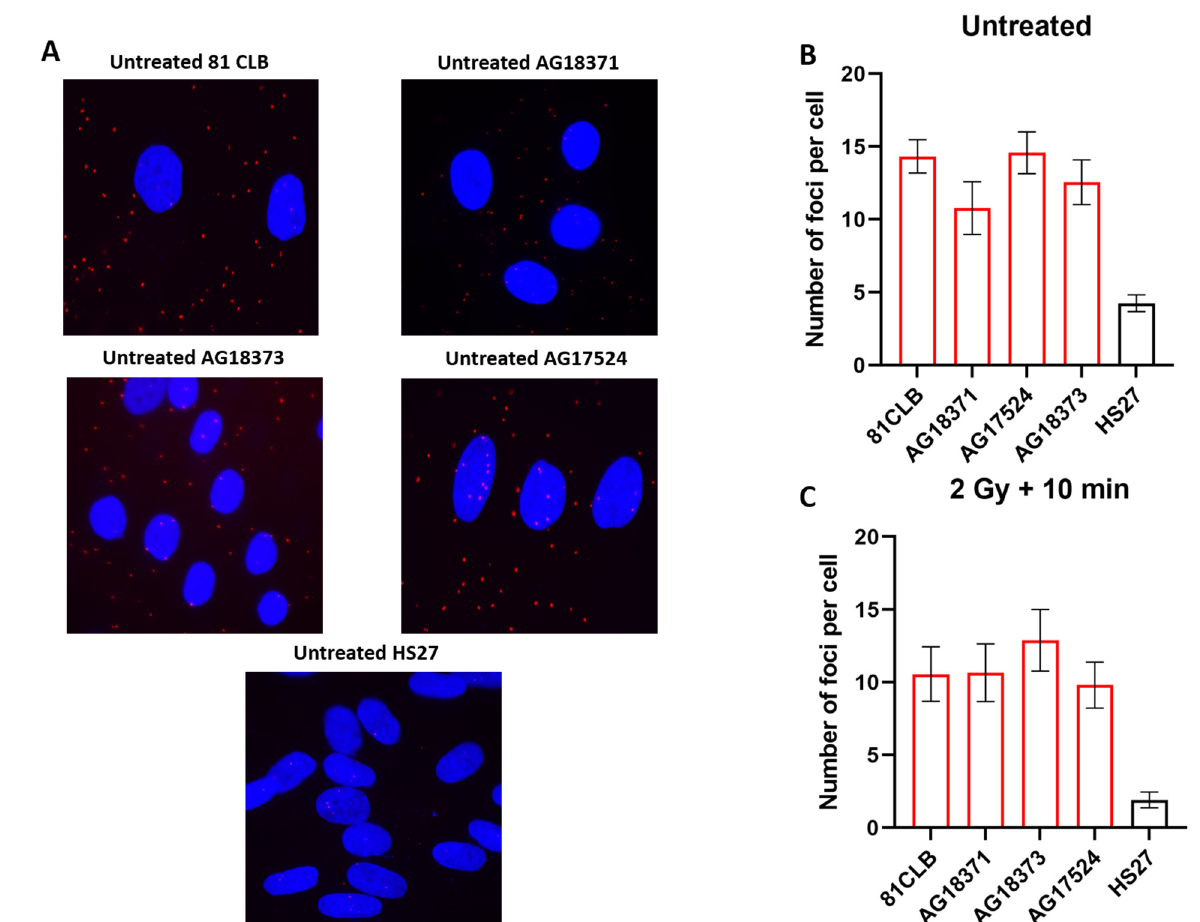
immunoblots with total or cytoplasmic protein extracts of the indicated non-irradiated RTS and control fibroblasts tested in this study.